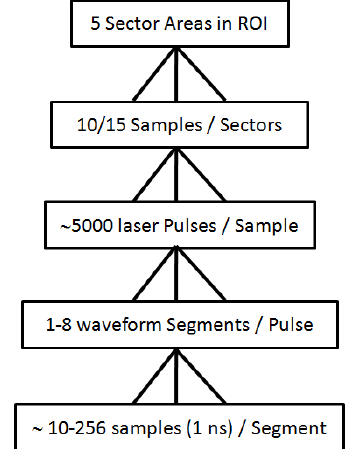
Figure 3. Plot of eight waveforms of the outgoing